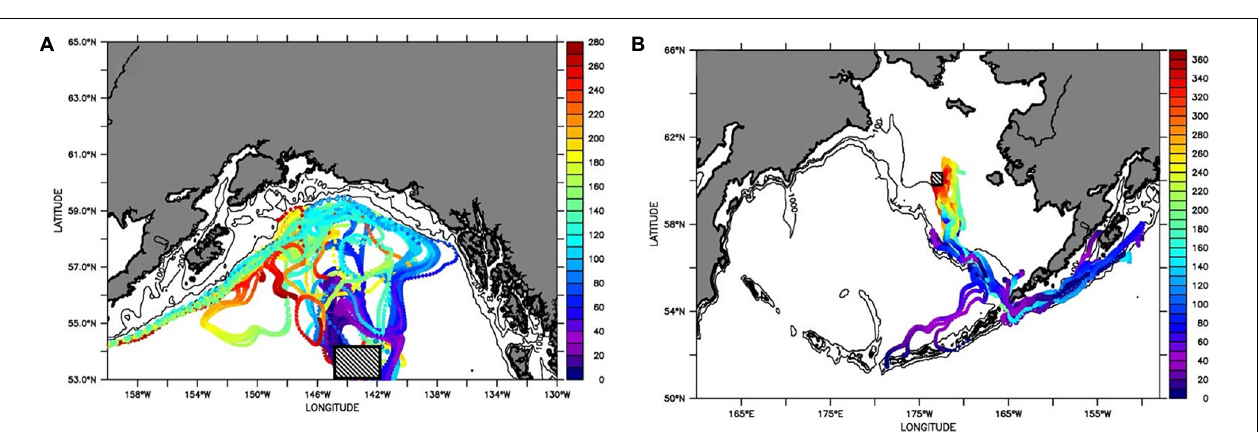
FIGURE 13 | Particle tracking at (A) 200 m depth in the Eastern Pacific subpolar gyre for a time period of 8 months (280 days), and (B) at 50 m depth in the Bering Sea for the time period of 12 months (365 days). Vertical scale bar indicates (A) number of days in the forward tracked particles since their release near 53 ◦ N, 143 ◦ W on April 15, 2012; and for (B) days of the backward tracked particles using 60 ◦ N, 173 ◦ W as ending location on April 15, 2017 (with initial release in April 15, 2016). Blue colors indicate shorter, and red color indicate longer time intervals since release. Initial release is indicted by a square. The hydrodynamic output from the model hindcasts is described by Coyle et al. (2019) and Kearney et al.